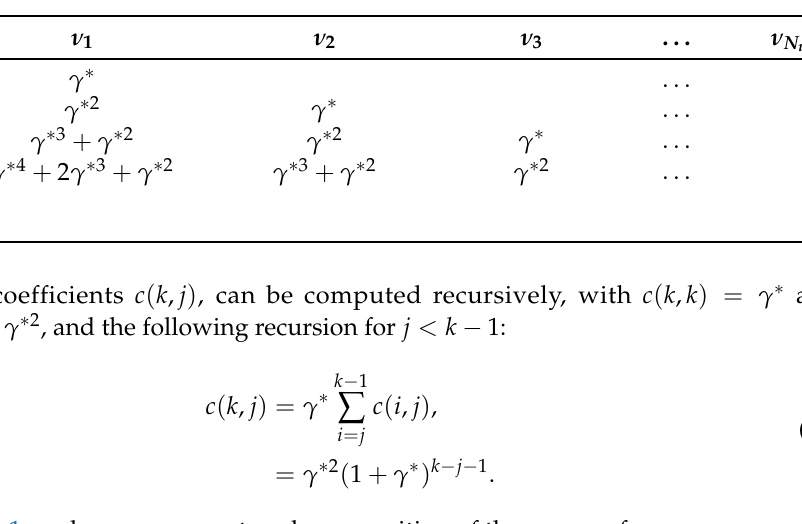
Table 1. Power series coefficients c ( k , j ) ( k th row, j th column) representing the coefficient of the j th equivalent noise into the k th power